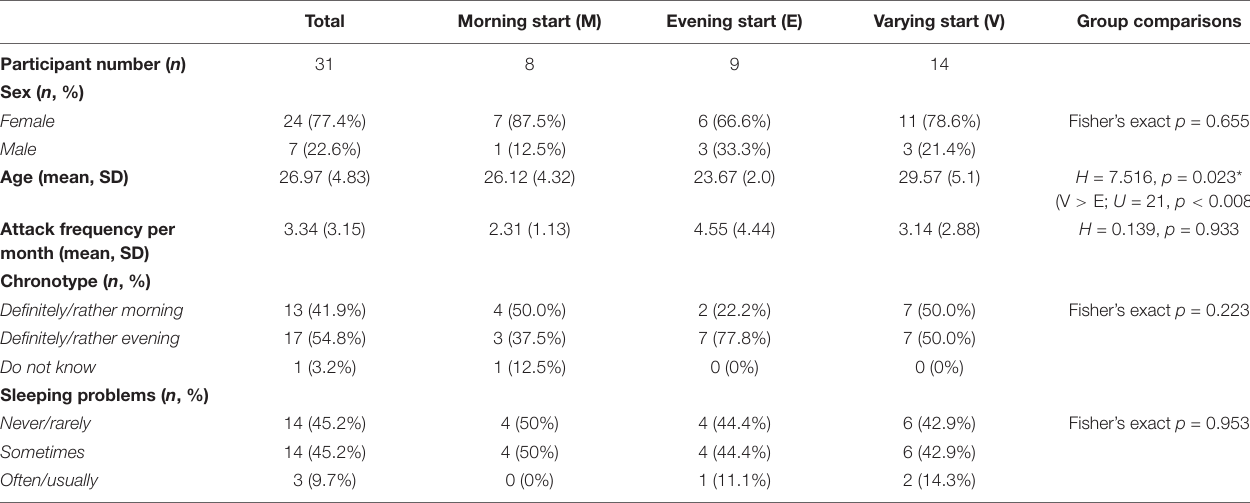
TABLE 1 | Details of the Study 1 sample and statistical results of the comparison between M circ